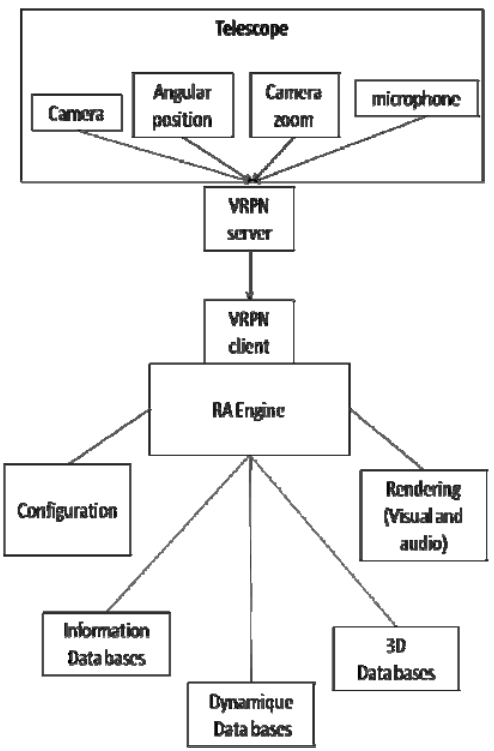
Fig. 5. Diagram of the augmented reality application.